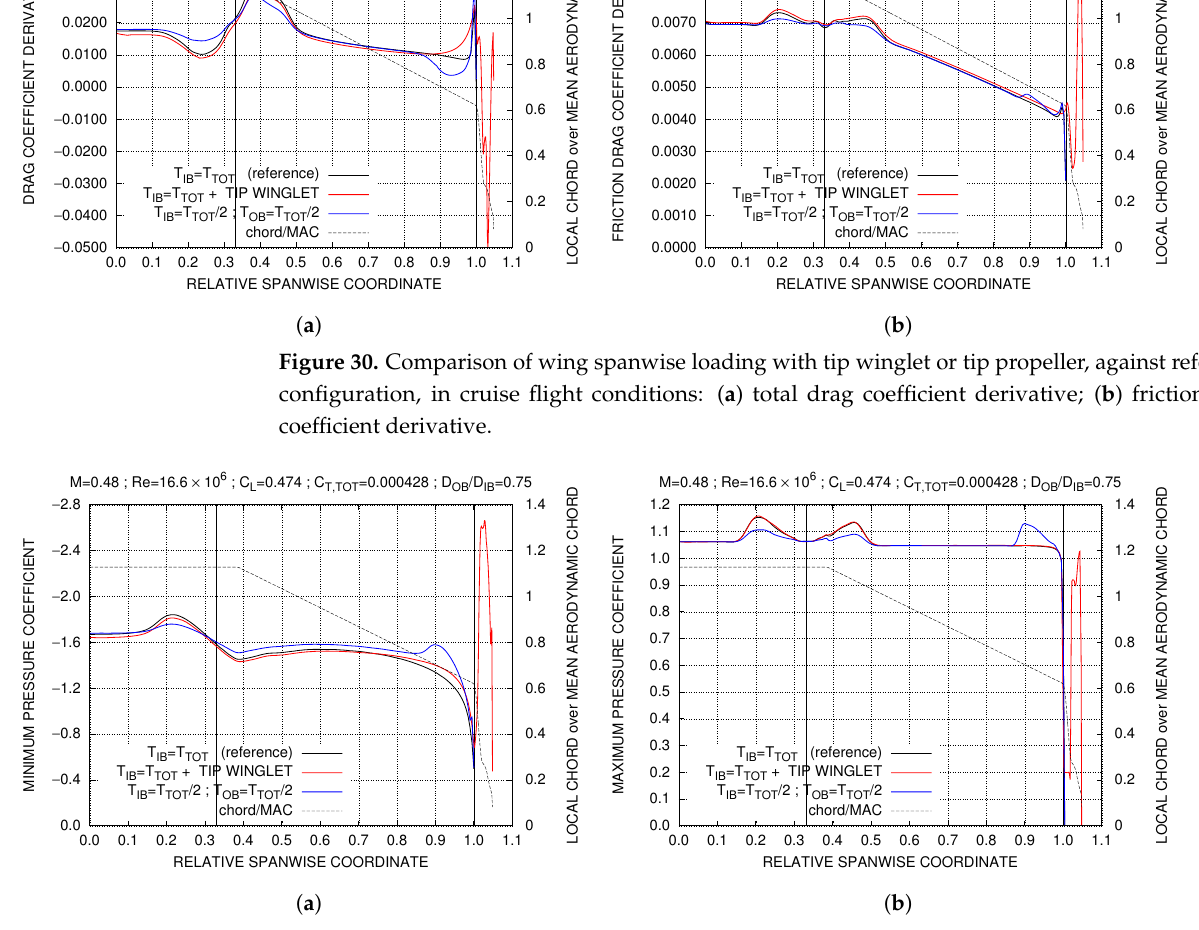
Figure 31. Comparison of wing spanwise loading with tip winglet or tip propeller, against ref- erence configuration, in cruise flight conditions: ( a ) minimum pressure coefficient; ( b ) maximum pressure